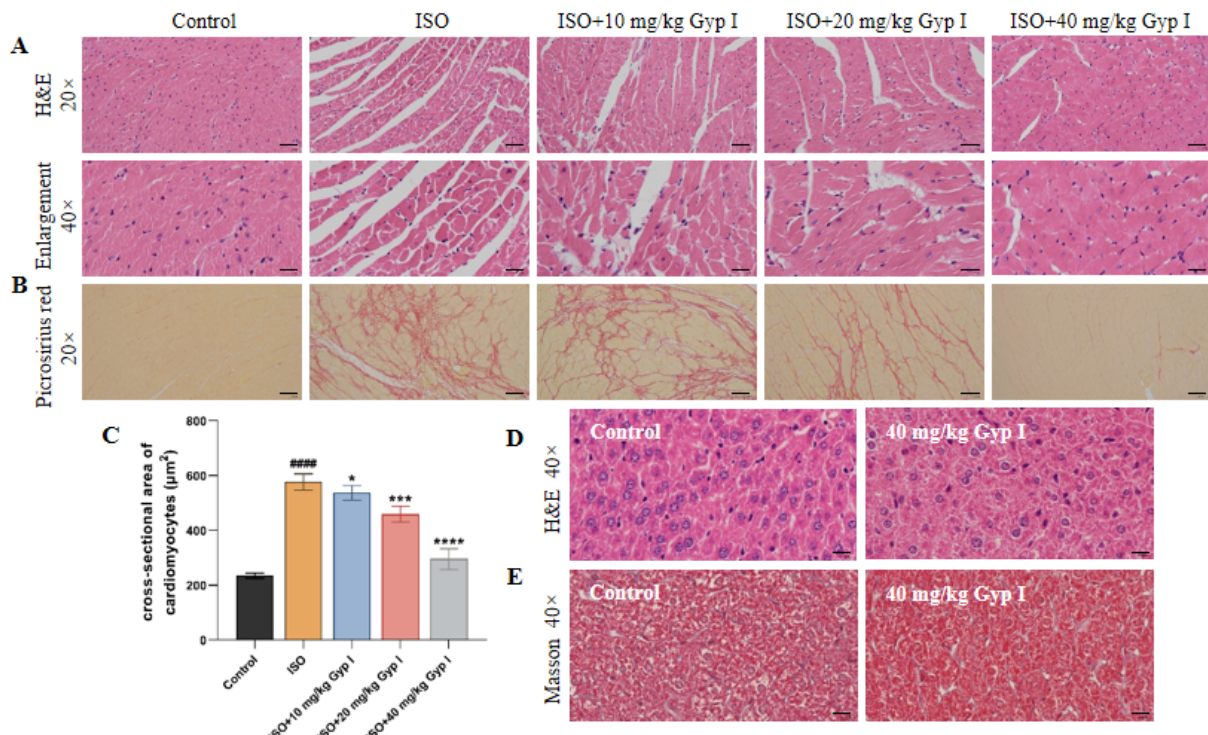
Figure 9. Representative images of histopathological studies of heart and liver sections: ( A ) H&E staining of heart sections. ( B ) Sirius red staining of heart sections. ( C ) Cardiomyocytes cross-sectional area ( μ m 2 ) in tissue after H&E staining. ( D ) Liver section H&E staining. ( E ) Masson staining of liver section (Enlargement: 20×, Scale bar: 100 μ m; Enlargement: 40×, Scale bar: 50 μ m; n = 3, mean ± SD, #### p < 0.0001 compared with Control group; * p < 0.05, *** p < 0.001, **** p < 0.0001 compared with ISO group).